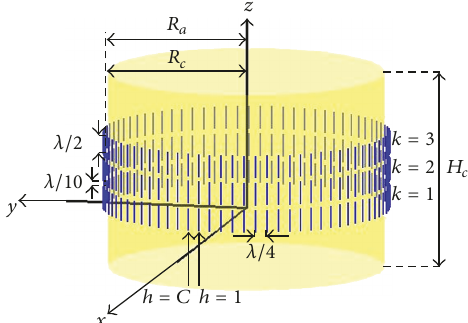
Figure 4: Antenna structure for the second application of the proposed algorithm: three-ring array of center-fed half-wavelength dipole antennas placed around a perfectly conducting cylinder.